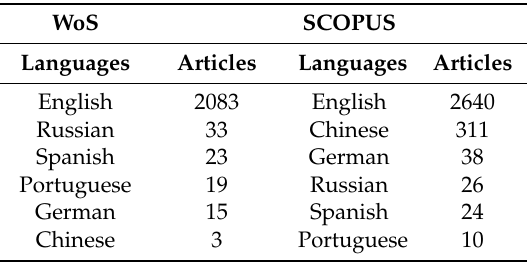
Table 4. Distribution by language.